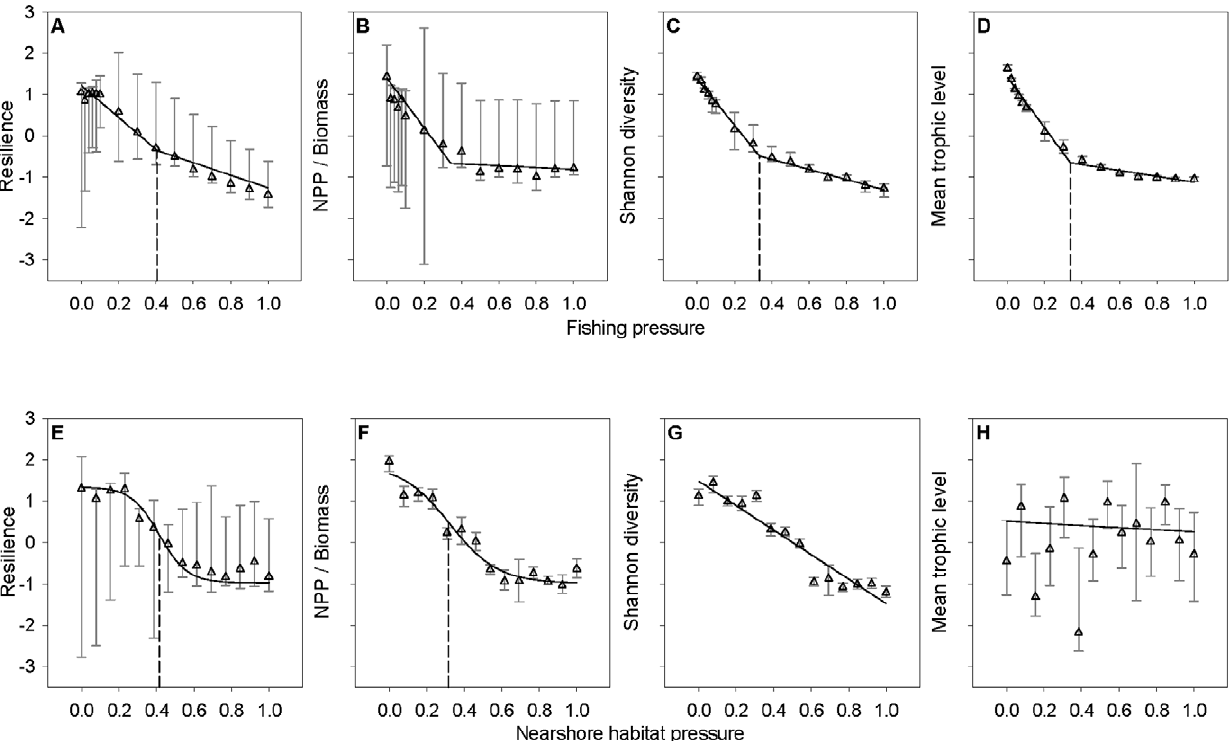
Figure 2. Model-generated relationships between 4 ecosystem attributes and increasing ecosystem-wide fishing (a-d) or nearshore habitat (e-h) pressure. The ecosystem attributes are resilience, NPP/Biomass, Shannon diversity, and mean trophic level. Open triangles indicate median values calculated from Monte Carlo simulated Ecopath with Ecosim data ( n =100), and error bars denote 95% confidence intervals. The solid lines represent best-fit functional relationships and the dotted lines designate significant utility thresholds estimated using a nonparametric bootstrap resampling procedure ( n =10,000 for each Monte Carlo data set) (parameter values and significant utility thresholds listed in Table 2). NPP=net primary production. In this and following figures, the ecosystem attributes (y-axes) have been re-scaled so that larger values are considered unstressed rather than stressed. The pressure values have been re-scaled relative to the maximum simulated pressure, and are contained within the range [0, 1].